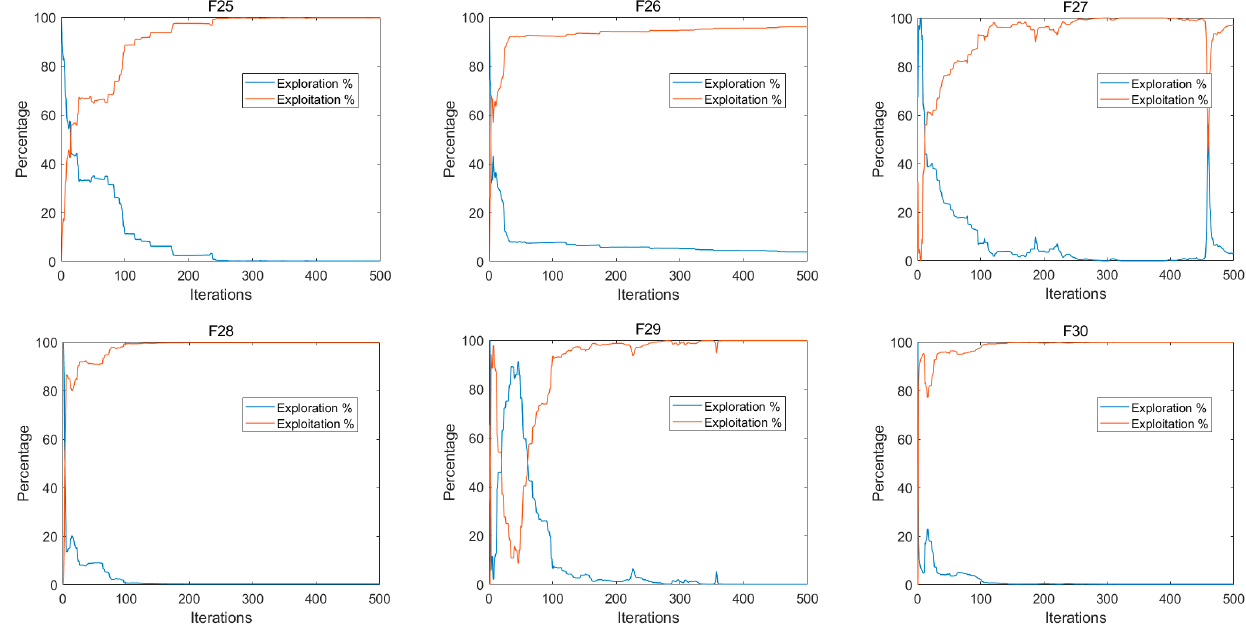
Figure 6. Exploration and exploitation phases for the MGTO algorithm using CEC2014.